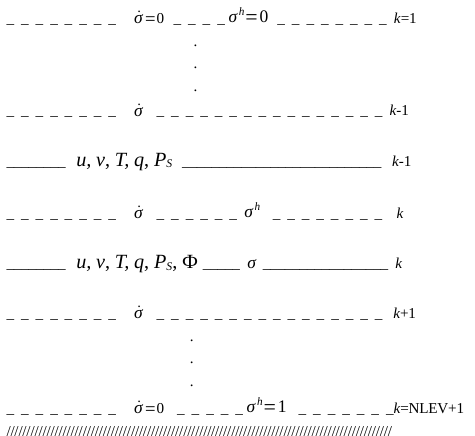
Figure 1. Schematic representation of field value distributions be- Fig. 1. Schematic representation of field value distributions be- tweeninteger(continuouslines)andsemiinteger(dashedlines)lev- tween integer (continuous lines) and semi-integer (dashed lines) els in the GLOBO model. levels in the GLOBO